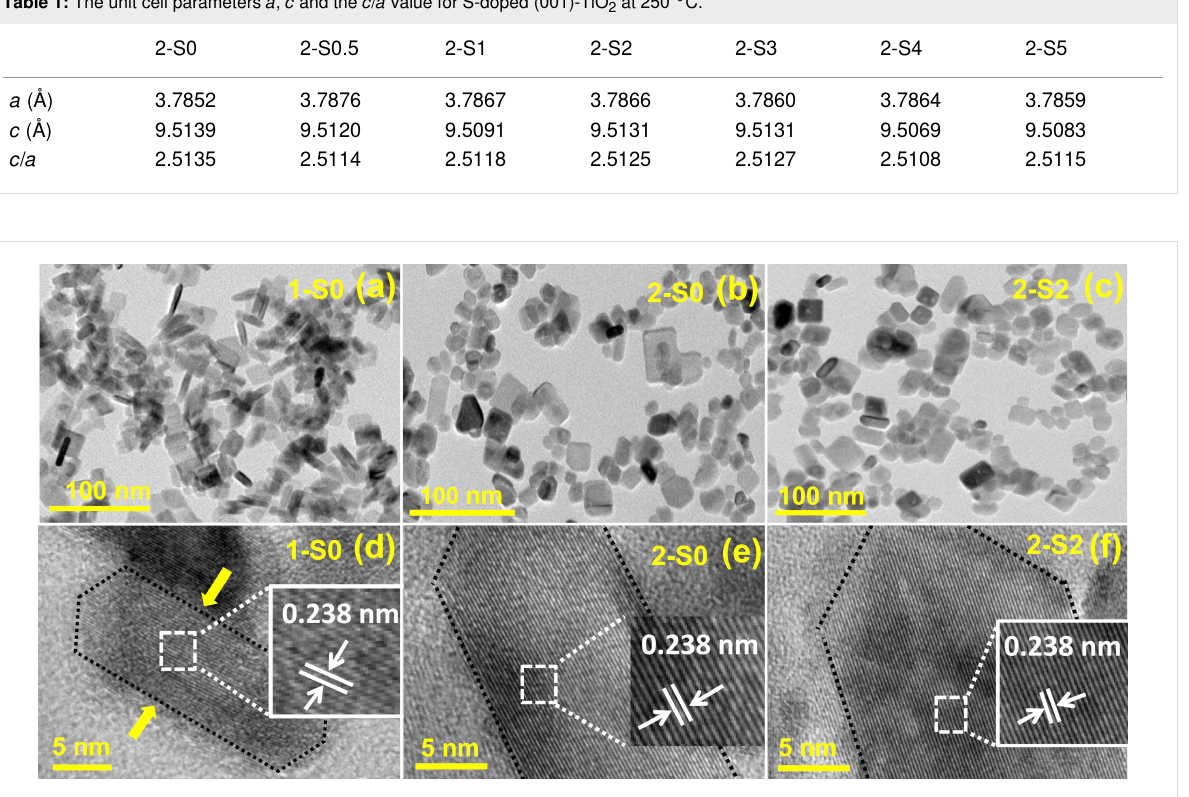
bottom square surfaces (indicated by the arrow) are the (001) faces [29]. For the samples synthesized at 250 °C, the TEM images (Figure 2b and Figure 2c) of the undoped 2-S0 and S-doped 2-S2 show that the edges and corners of some of the square particles become blurred. The HRTEM images (Figure 2e and Figure 2f) of the particles also exhibit lattice fringes associated with the (004) crystal